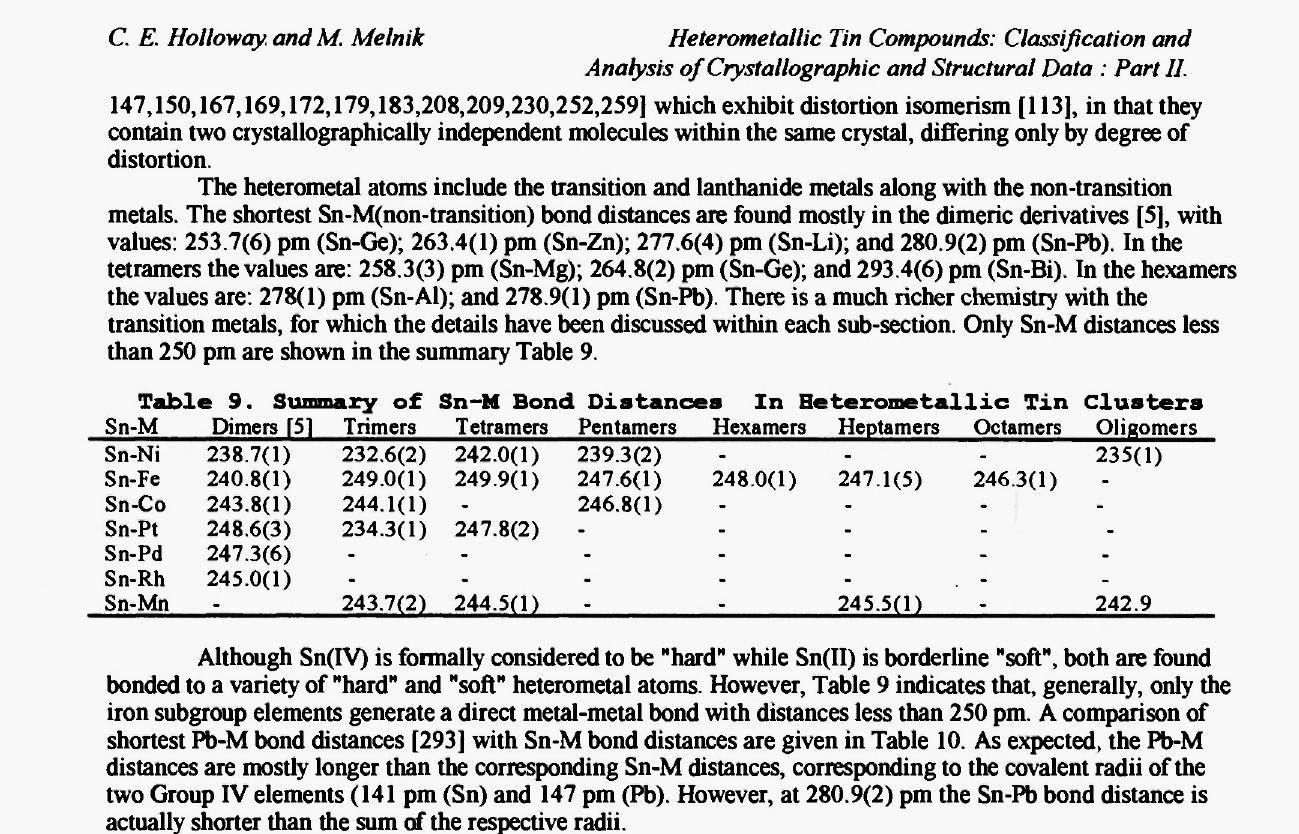
Table 10. Summary of the Sn-M and Pb-M [293] bond distances in Heterometal